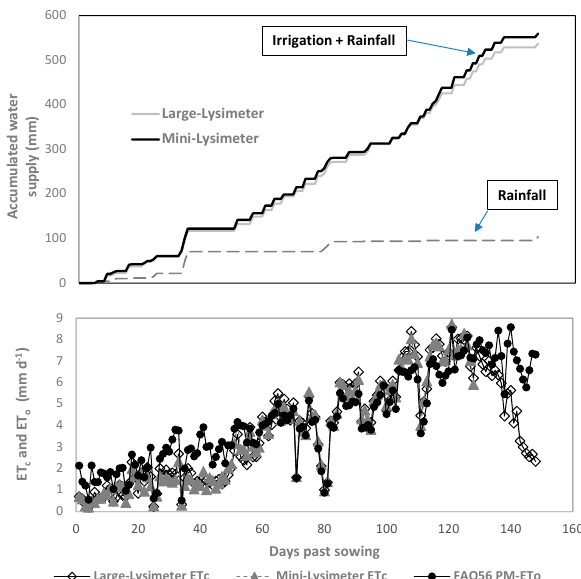
Figure 4. Seasonal rainfall and total water supply to each lysimeter for barley (top). Daily ET c values for barley from each weighing lysimeter and the computed grass FAO56 PM-ET o from the daily weather data (bottom).